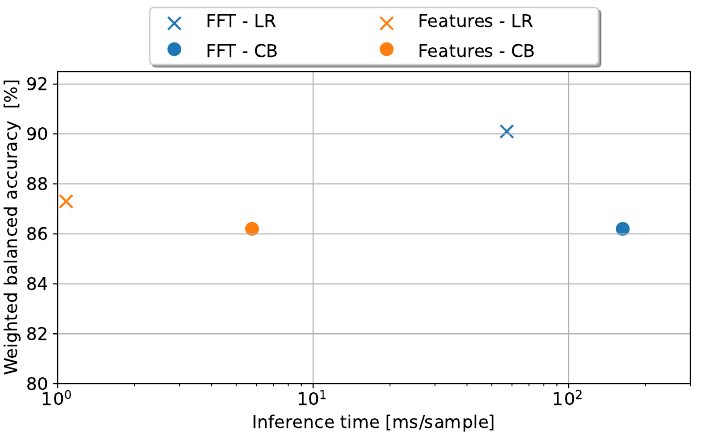
Figure 13. The computation time required to make a prediction vs. the weighted balanced accuracy of classifiers trained with different input